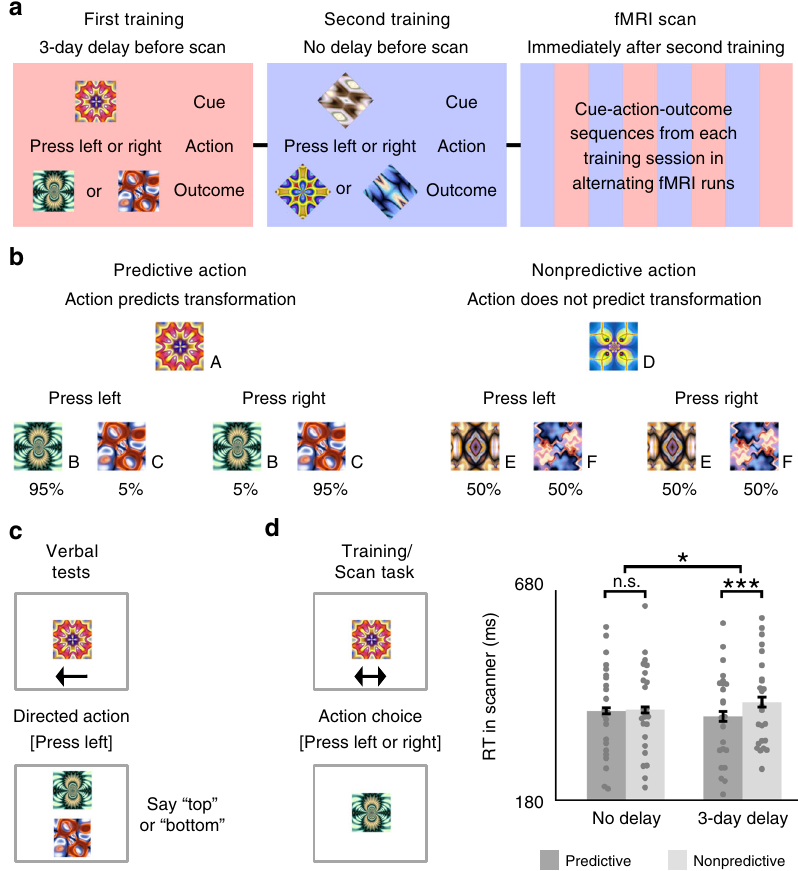
Fig. 1 Design and RT. a The fi rst training session was proctored 3 days before the fMRI scan, while the second training session was proctored immediately before the scan. To reduce interference, fractal stimuli in each session were masked to be either squares or diamonds in shape. The fMRI scan included four runs for each of the two training sets. b For predictive actions, given the cue, one outcome appeared with 95% probability when the left button was pressed and the other with 95% probability when the right button was pressed. For nonpredictive actions, given the cue, either outcome appeared with 50% probability when the left or right button was pressed. c In verbal tests outside the scanner, participants spoke aloud either “ top ” or “ bottom ” to indicate which outcome was expected given the cue and action. d For each trial in the fMRI scanner, participants chose to press either a left-hand or right- hand button to replace a cue with an outcome. While choice RT was similar for predictive and nonpredictive actions immediately after training, it was faster for predictive vs. nonpredictive actions after a 3-day delay. Error bars indicate ±1 SEM of the difference between predictive and nonpredictive actions at each timescale. *** p < 0.001; * p < 0.05 (paired t -tests). Source data are provided as a Source Data fi